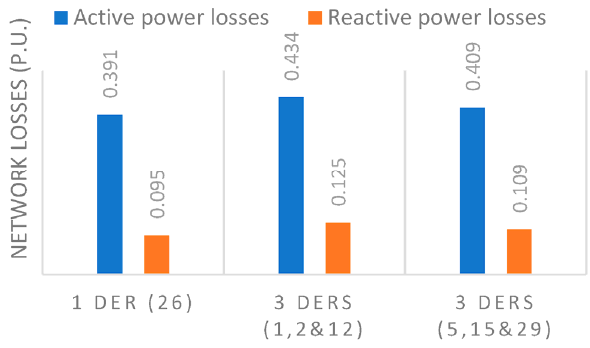
Figure 12. Losses comparison. Table 3. DER locations.